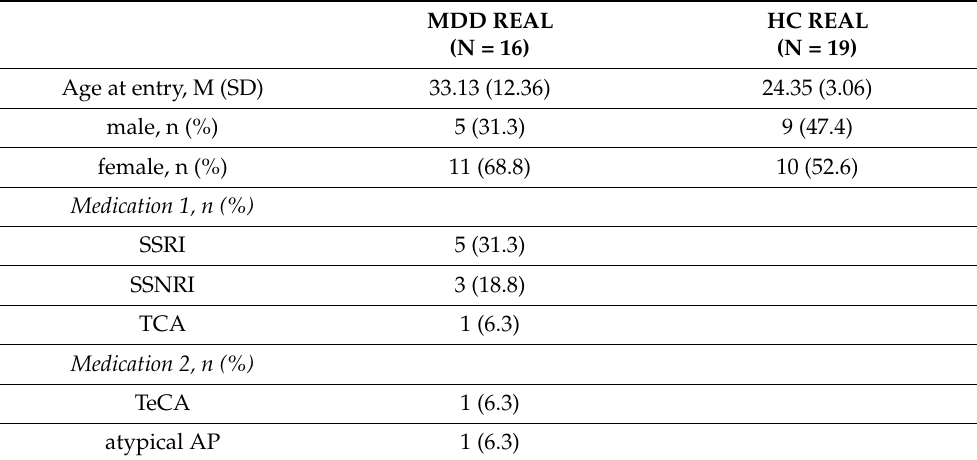
Table 1. Age, sex, and